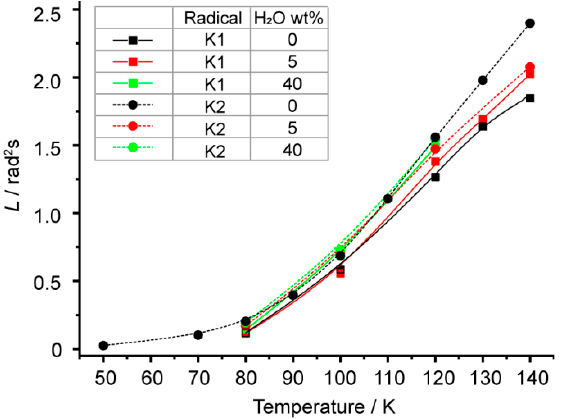
Figure 2. Temperature dependence of the motional parameter L for used nitroxide spin probe in ILs and IL/water mixtures. Color lines are guides for the eye.